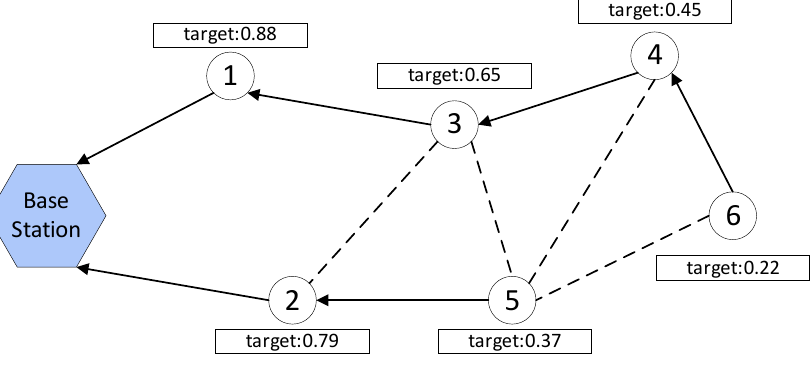
Figure 3. Path discovery